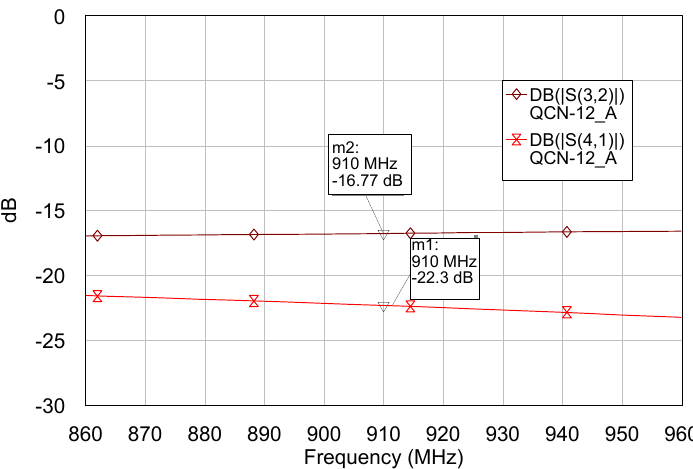
Figure 4. Isolation performance of QCN 12 A Hybrid Coupler.